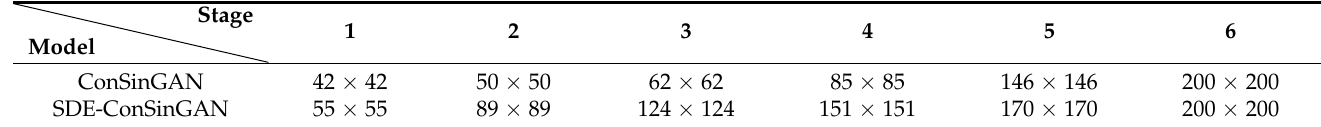
Table 1. Comparison of image size-adjustment effects of two